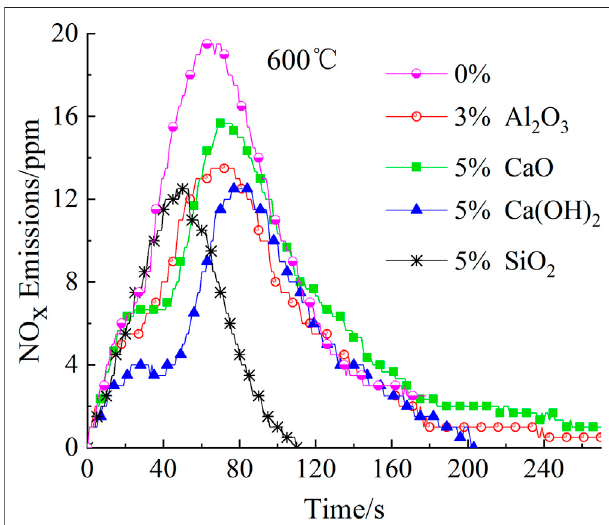
FIGURE 4 | Emission curves for additives at their respective optimal mass fractions at 600 ° C.